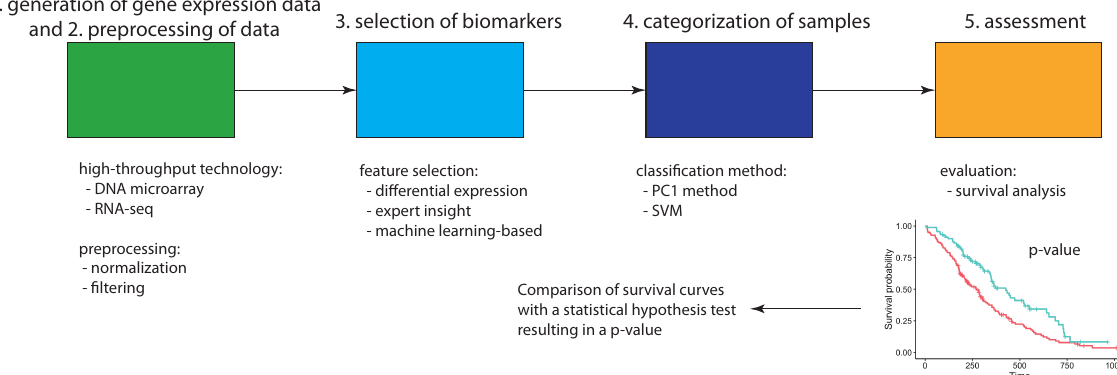
Figure 2. General procedure used by studies for establishing prognostic biomarkers. The first three steps involve the generation and preprocessing of expression data and the selection of potential signatures. The fourth step uses the signature for a categorization of patient samples followed by an evaluation of the quality of this categorization by means of survival analysis.